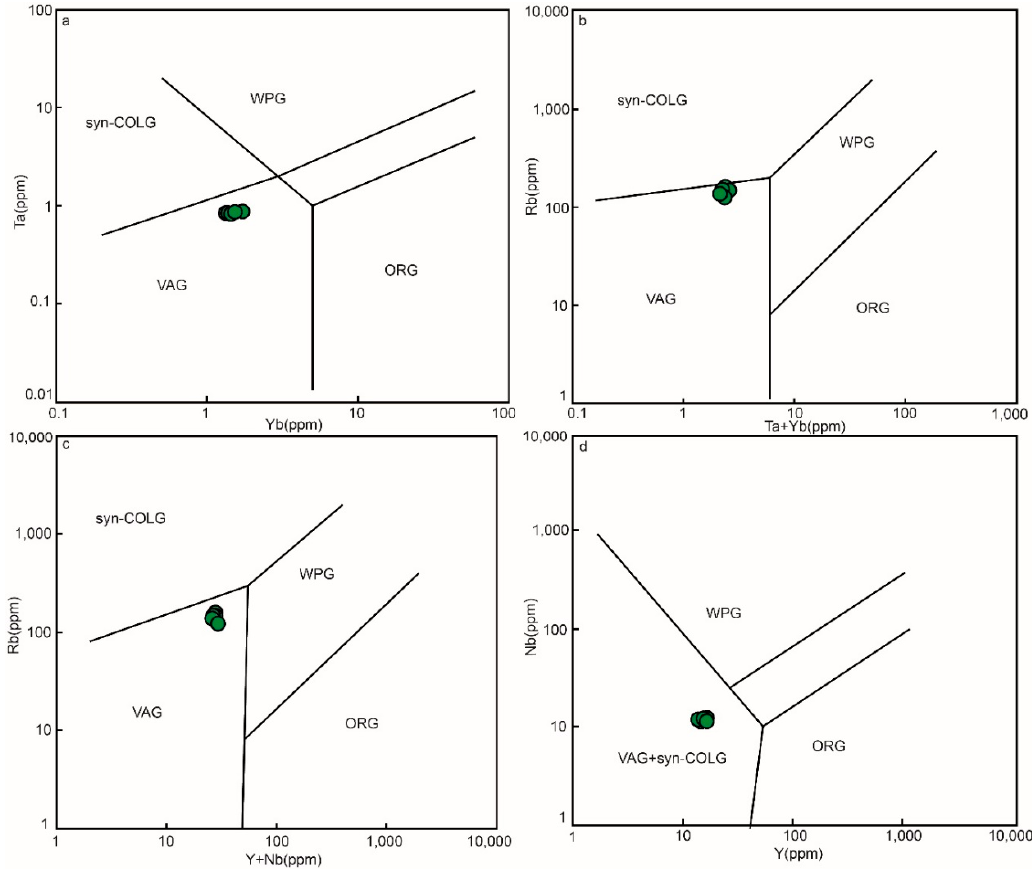
Figure 16. Tectonic discrimination of Hucunnan granodiorite: ( a ) Ta vs. Yb, ( b ) Rb vs. (Yb + Ta), ( c ) Nb vs. Y, and ( d ) Rb vs. (Y + Nb); after [101]. VAG, volcanic arc granite; ORG, oceanic ridge granite; Syn-COLG, syn-collision granite; WPG, intra-plate granite.